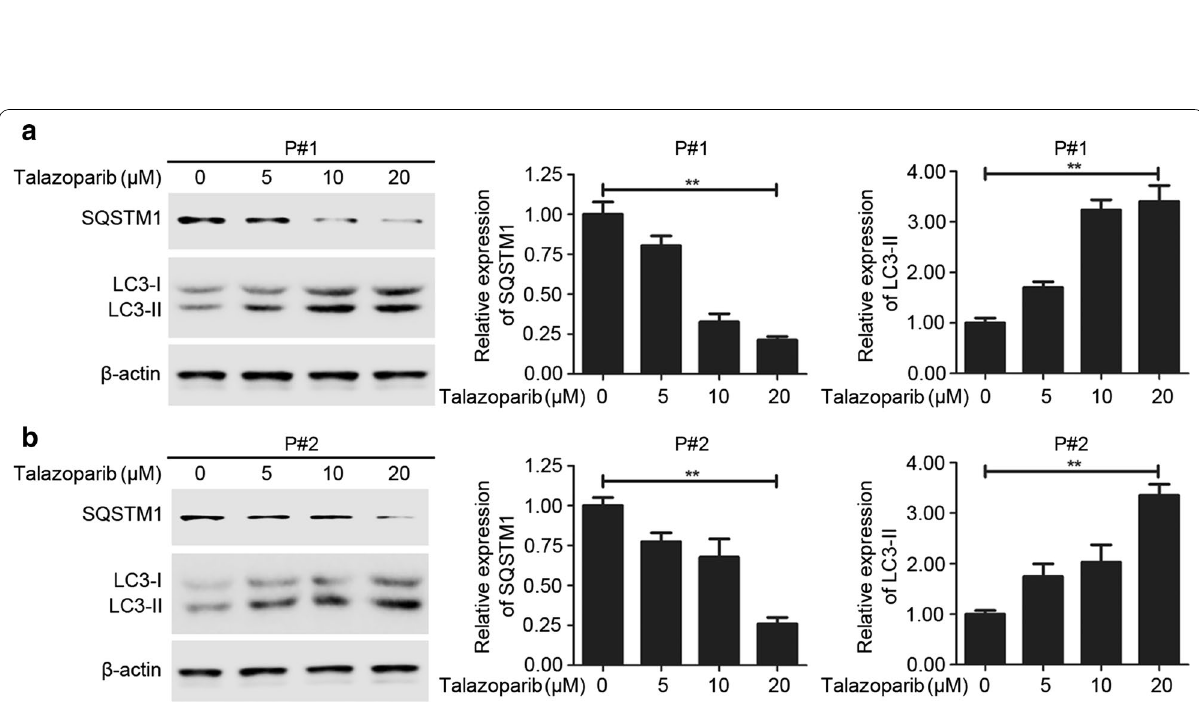
Fig. 3 PARP inhibitor talazoparib triggered autophagy initiation in CML cells. Analysis of autophagy markers, SQSTM1 and LC3-I/II in CML P#1 ( a ) and P#2 ( b ) cells after treatment with talazoparib (20 μM) for 48 h. Densitometric values were measured by Image J software and the data was shown as mean SD of three dependent experiments (** P < ±